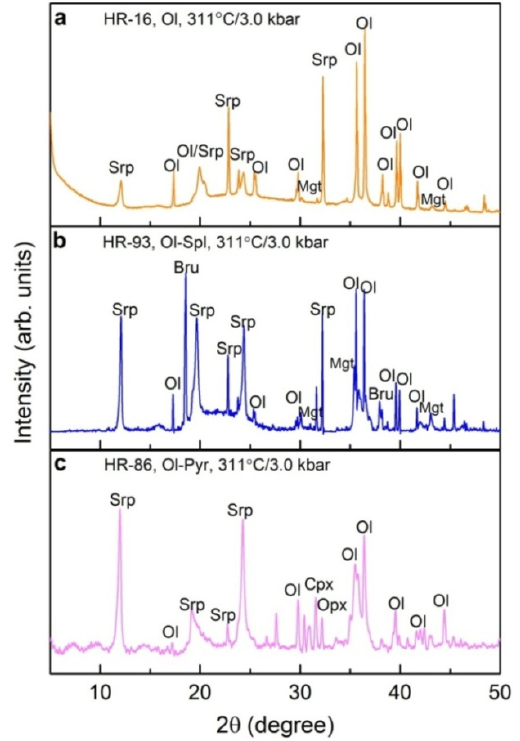
Figure 1. XRD patterns of typical experimental products of this study. ( a ) HR-16, 311 ◦ C/3.0 kbar. Olivine (Ol) was taken as the starting reactant; ( b ) HR-93, 311 ◦ C/3.0 kbar. A combination of olivine (Ol) and spinel (Spl) was used; ( c ) HR-86, 311 ◦ C/3.0 kbar. Mechanical mixtures of olivine (Ol) and pyroxene minerals (Pyr) were used. Mgt: magnetite, Bru: brucite, Cpx: clinopyroxene, Srp: serpentine.